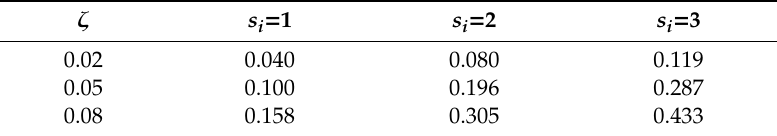
Table 4. Error ratio r Am